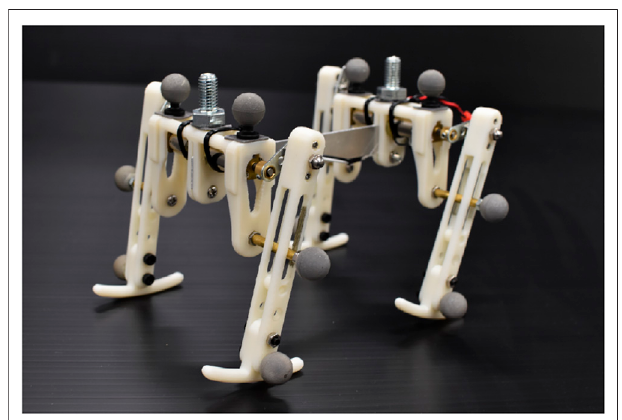
FIGURE 1 | Overview of the